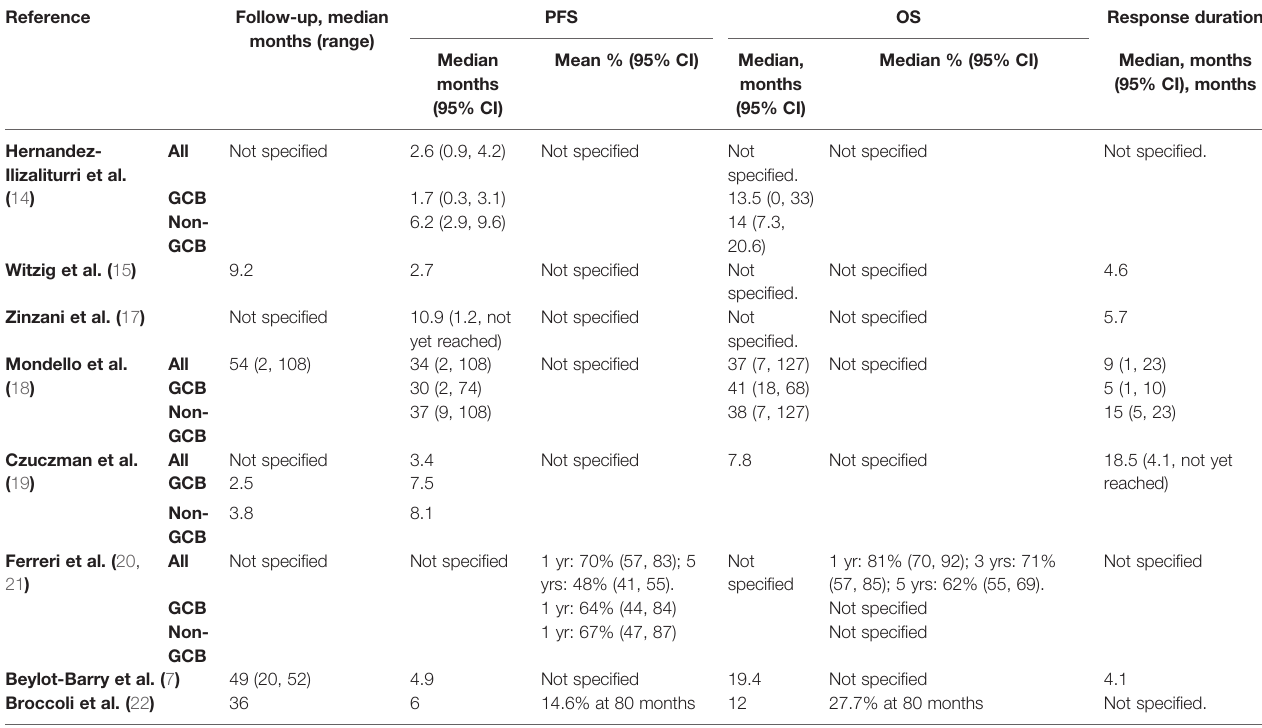
TABLE 4 | Progression-free survival (PFS) and overall survival (OS) in patients who received maintenance treatment consisting of lenalidomide monotherapy. Reference